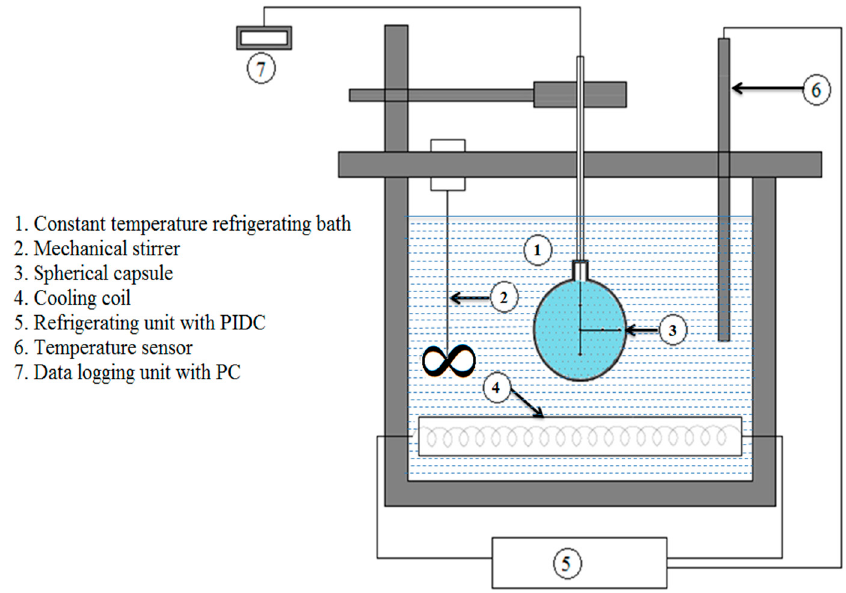
Figure 2. Schematic representation of the experimental setup [28].